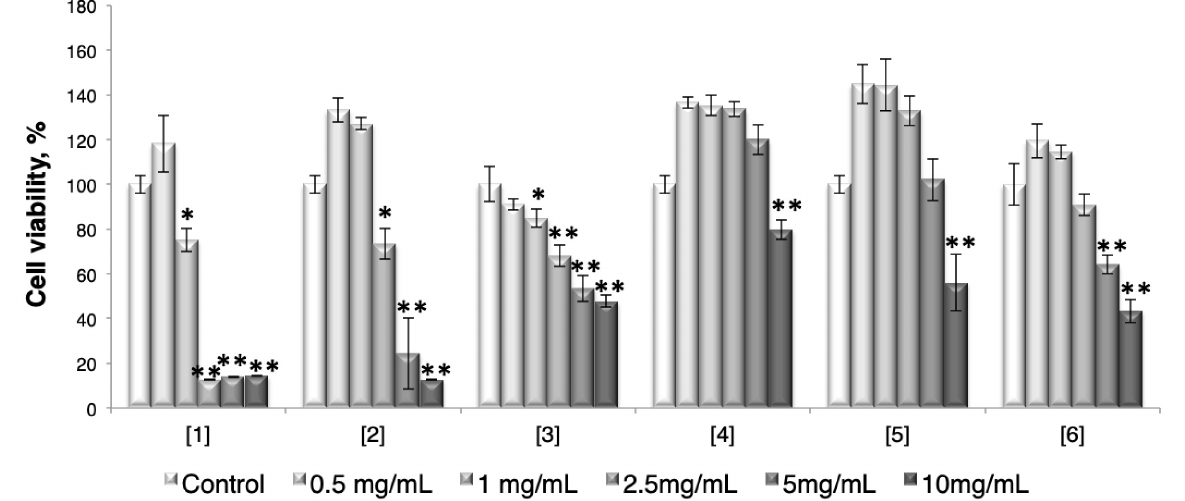
Figure 1. The effect of the extracts Seseli petraeum on cell growth of A549 human lung cancer cells. The 180 μl of A549 cell suspension from 5x10 4 cells/ml were plated in a 96-well microplate. A549 cells were exposed to different concentrations of extracts (0.5-10 mg/mL) for 24 h. Following incubation, the cells were treated with MTT [3-(4,5-dimethylthiazol-2yl)-2,4-diphenyltetrazolium bromide] solution (5 mg/mL) and incubated for 2 hours. The absorbance of dissolved formazan crystals was recorded at 540 nm by spectrophotometer (Thermo, Germany). Results are expressed as a percentage of viable cell amount. The non-treated cells were used as control. Each value represents the mean±standard deviation from three independent experiments performed in